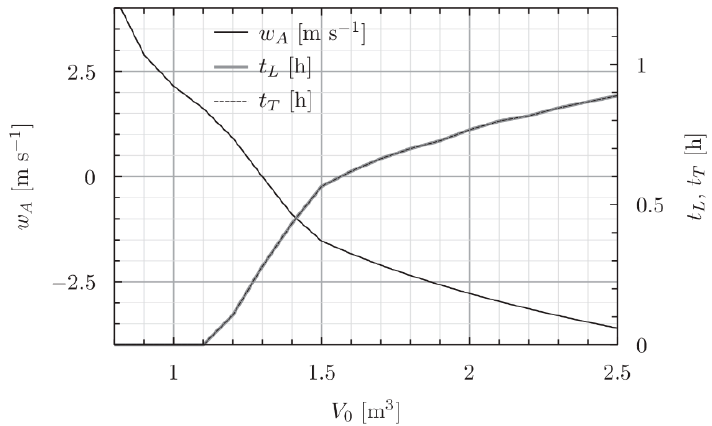
Figure 11. 24 October 2012 radiosonde data: thin line: derived vertical wind using Equations (1), (6), (7), (9), (10); dotted line: start of transition time from fully turbulent to laminar; thick gray line: time when flow becomes fully laminar (note that the lines for t T and t L overlap).